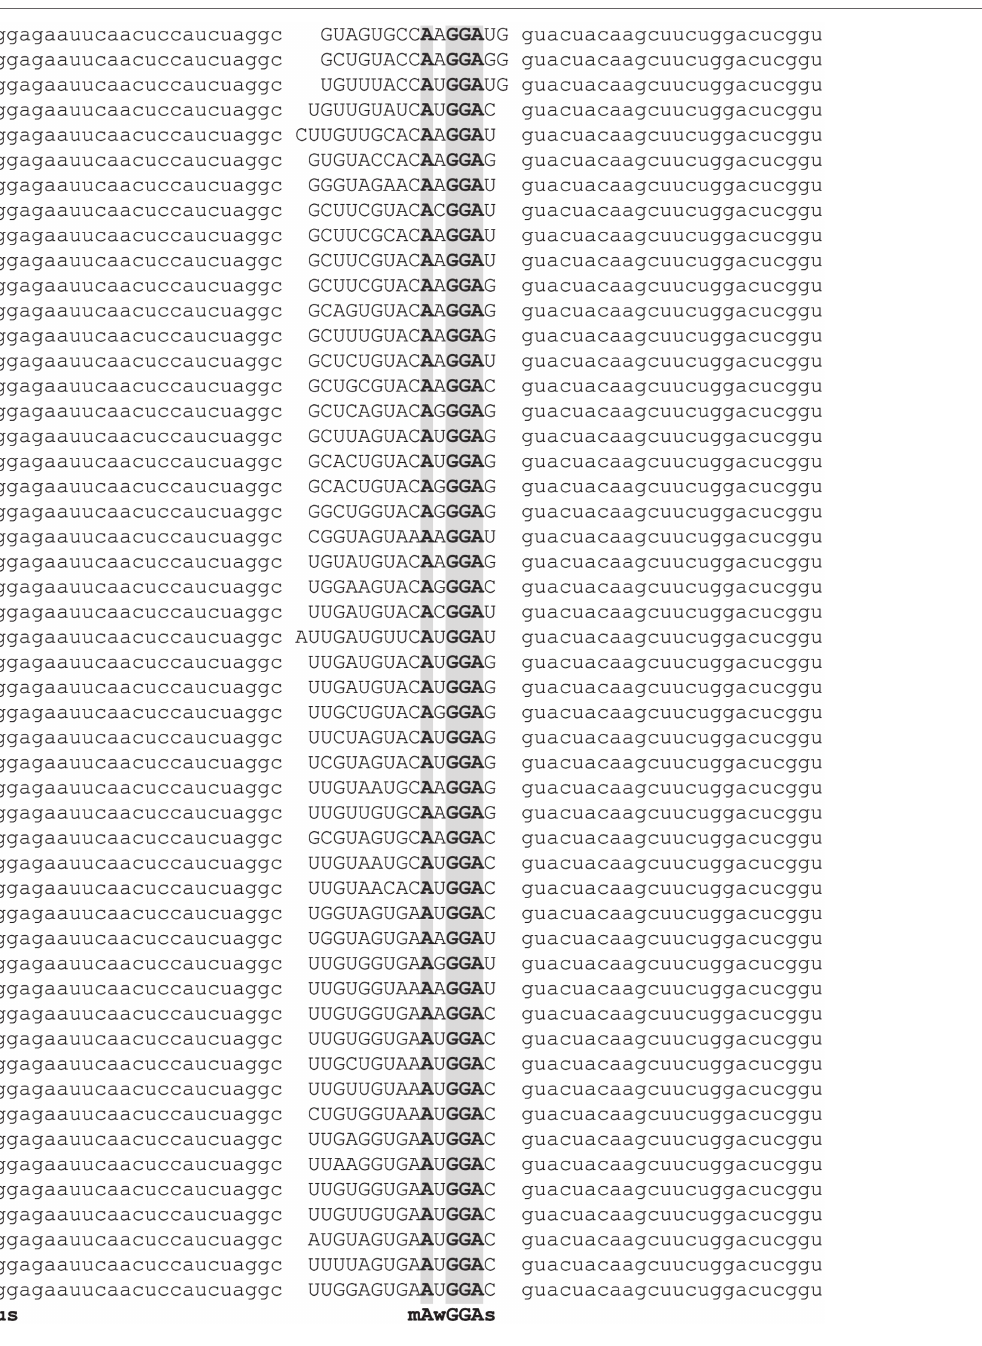
FIGURE 2 | Alignment of SELEX-derived RNA templates. Following nine and ten cycles of enrichment, cDNAs corresponding to high-affinity C. jejuni CsrA RNA ligands were sequenced and aligned using Clustal Omega (Li et al., 2015) to generate the consensus binding sequence mAwGGAs. Gray shading indicates nucleotides present in every SELEX